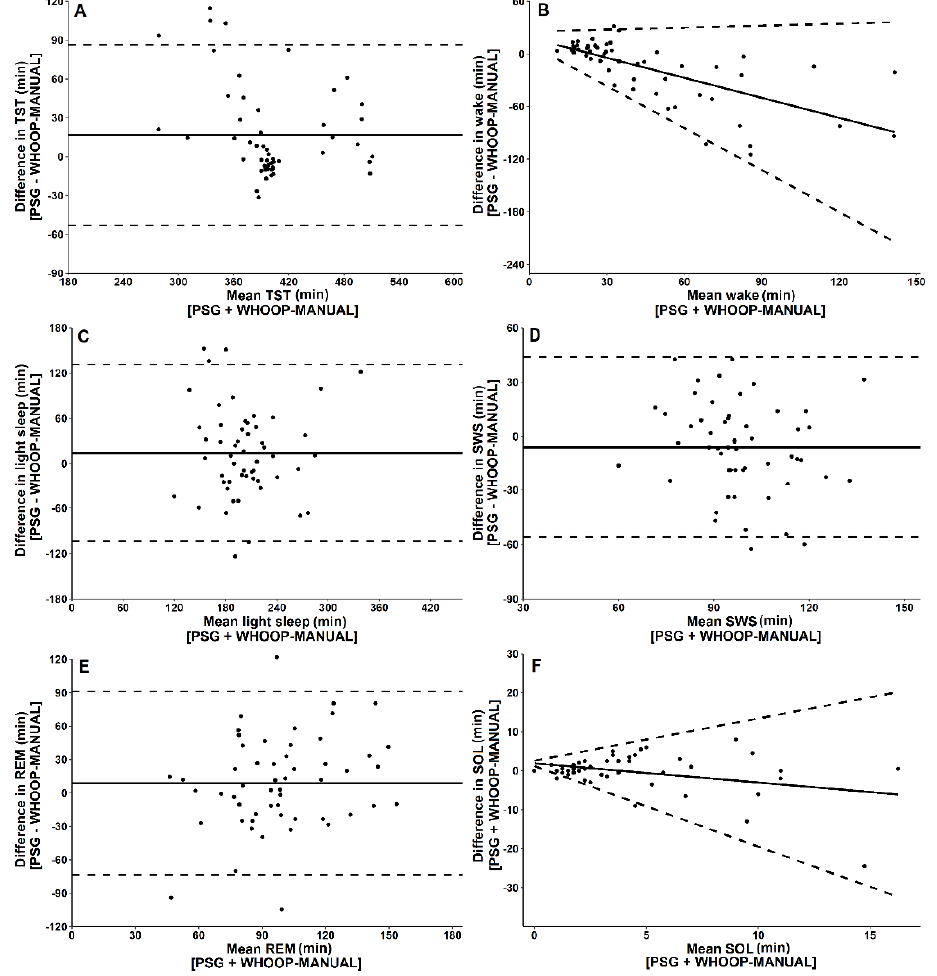
Figure 3. Bland–Altman plots for WHOOP-MANUAL and PSG-derived measures of ( A ) total sleep time (TST), ( B ) wake time, ( C ) light sleep, ( D ) slow wave sleep (SWS), ( E ) rapid eye movement sleep (REM) and ( F ) sleep onset latency (SOL). Data points represent one sleep opportunity. The x-axes represent the mean of the values obtained from WHOOP-MANUAL and PSG. The y-axes represent the difference between the values, such that positive values indicate WHOOP-MANUAL overestimates relative to PSG and negative values indicate WHOOP-MANUAL underestimates relative to PSG. Solid horizontal lines indicate the mean bias from PSG, and broken lines indicate the 95% limits of agreement (±1.96 standard deviations) [20].